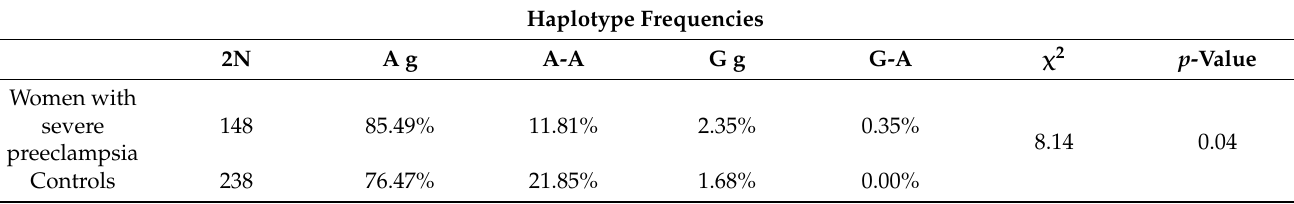
Table 4. Haplotype frequencies for the Nla IV and Nco I polymorphisms at the promoter region of the TNF-a gene in severe preeclampsia and controls. Haplotype